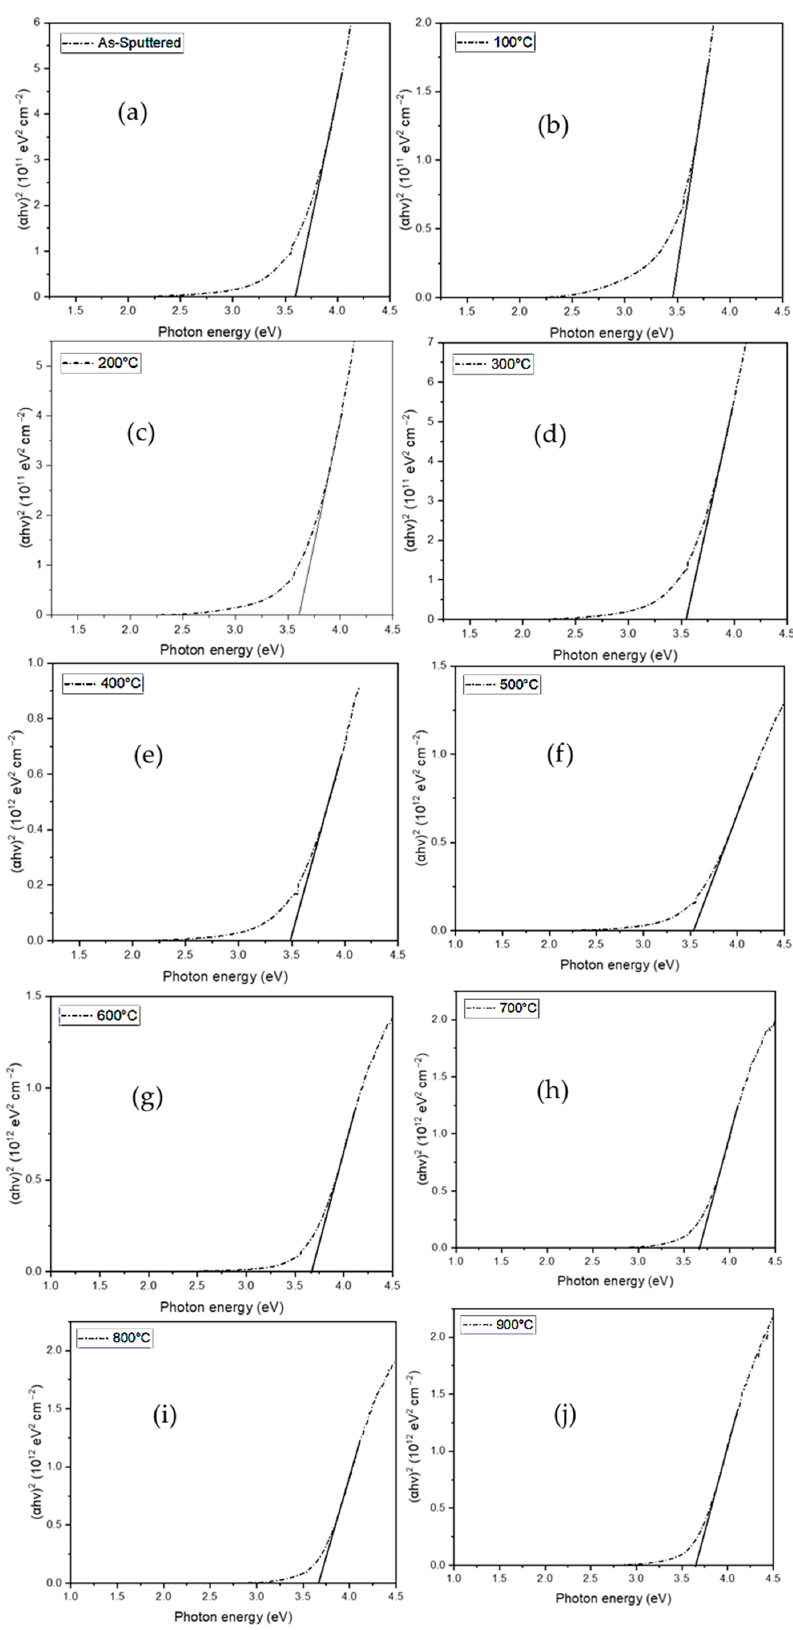
Figure 4. ( a – j ): Tauc plots of the Cu 2 In 2 O 5 thin films annealed at different temperatures.